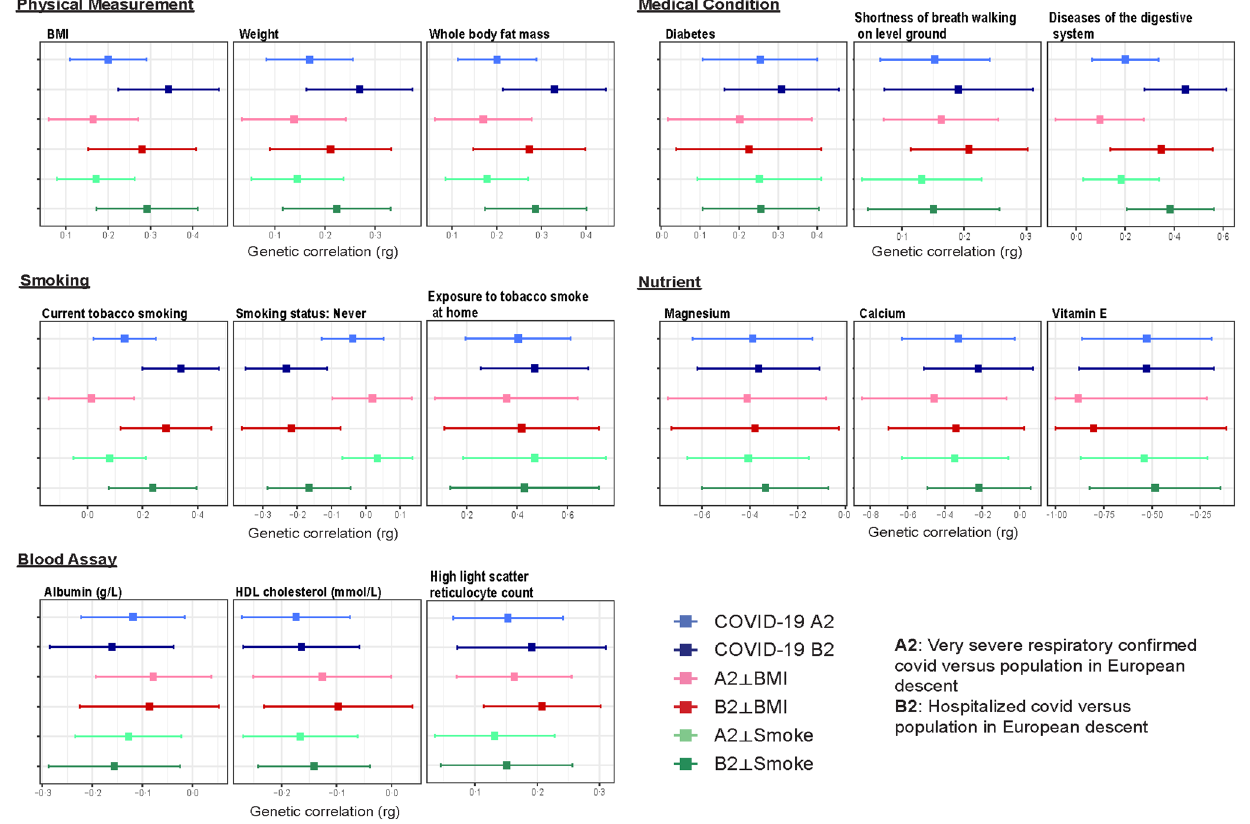
Figure 3. The pairwise genetic correlation of COVID-19 disease severity and selected